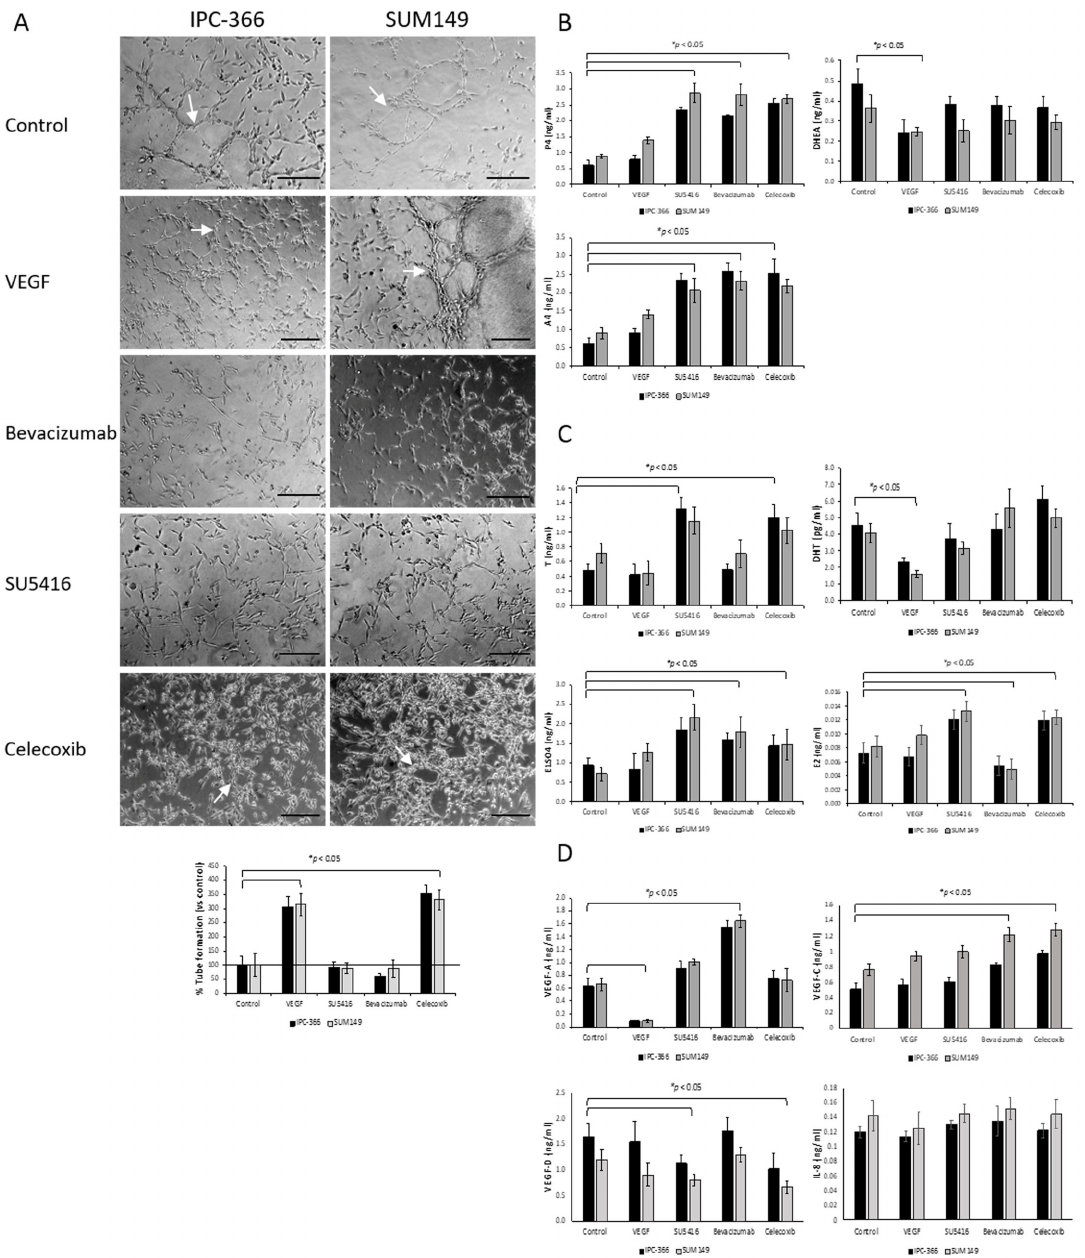
Figure 4. Tube formation results. ( A ) Images × 10 of IPC-366 and SUM149 vascular-like structures (arrows) formed in control and treated groups treated with a final concentration of 1.5 uM for VEGF, SU5416, bevacizumab and celecoxib. Bar graph represents percentage of number of tubes formed at 6 h respect to control group. ( B ) Steroid precursor (P4, DHEA, A4); ( C ) sexual steroids (T, DHT, E2, E1SO4) and ( D ) angiogenic growth factors (VEGF-A, VEGF-C, VEGF-D, IL-8) in culture media of IPC-366 (black) and SUM149 (grey) after tube formation assay. * Denoted significant differences ( p < 0.05) between control and treated groups. Scale bar 200 µ